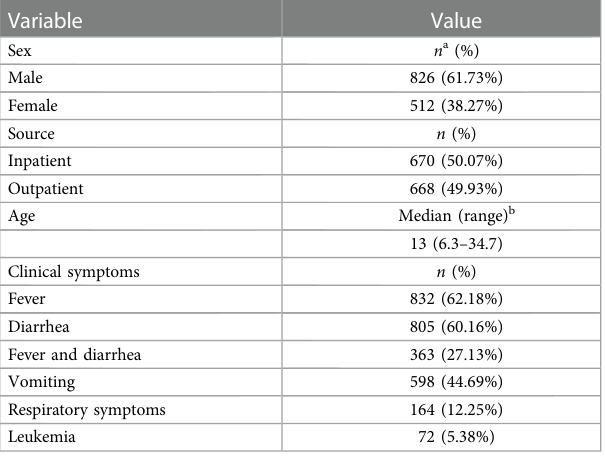
TABLE 2 The clinical information of 1,338 Salmonella